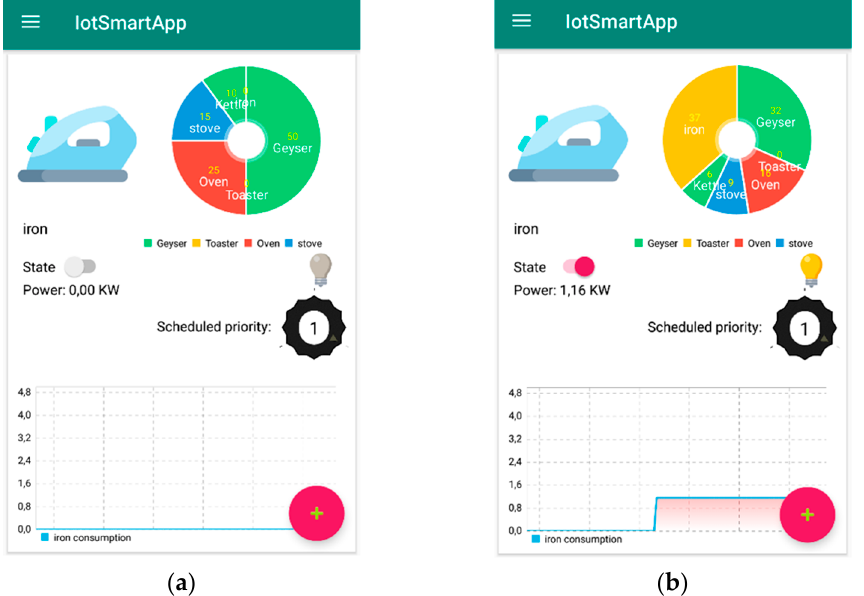
Figure 12. Home Automation via the IoTSmartApp; ( a ) Appliance is turned off; ( b ) Appliance is turned on.